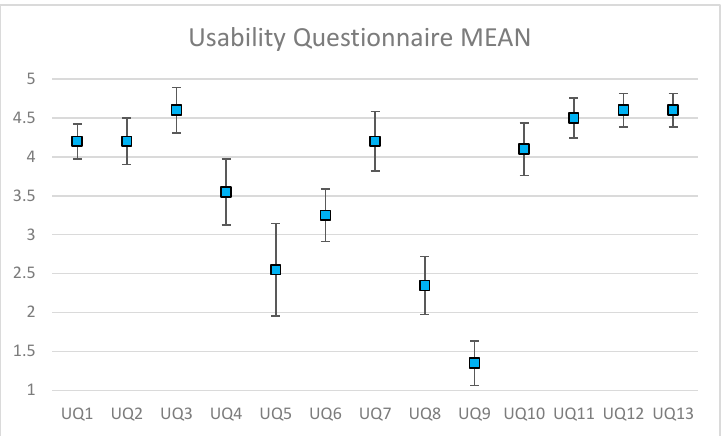
Figure 13. Usability questionnaire results: mean and confidence interval (alpha = 0.05) .